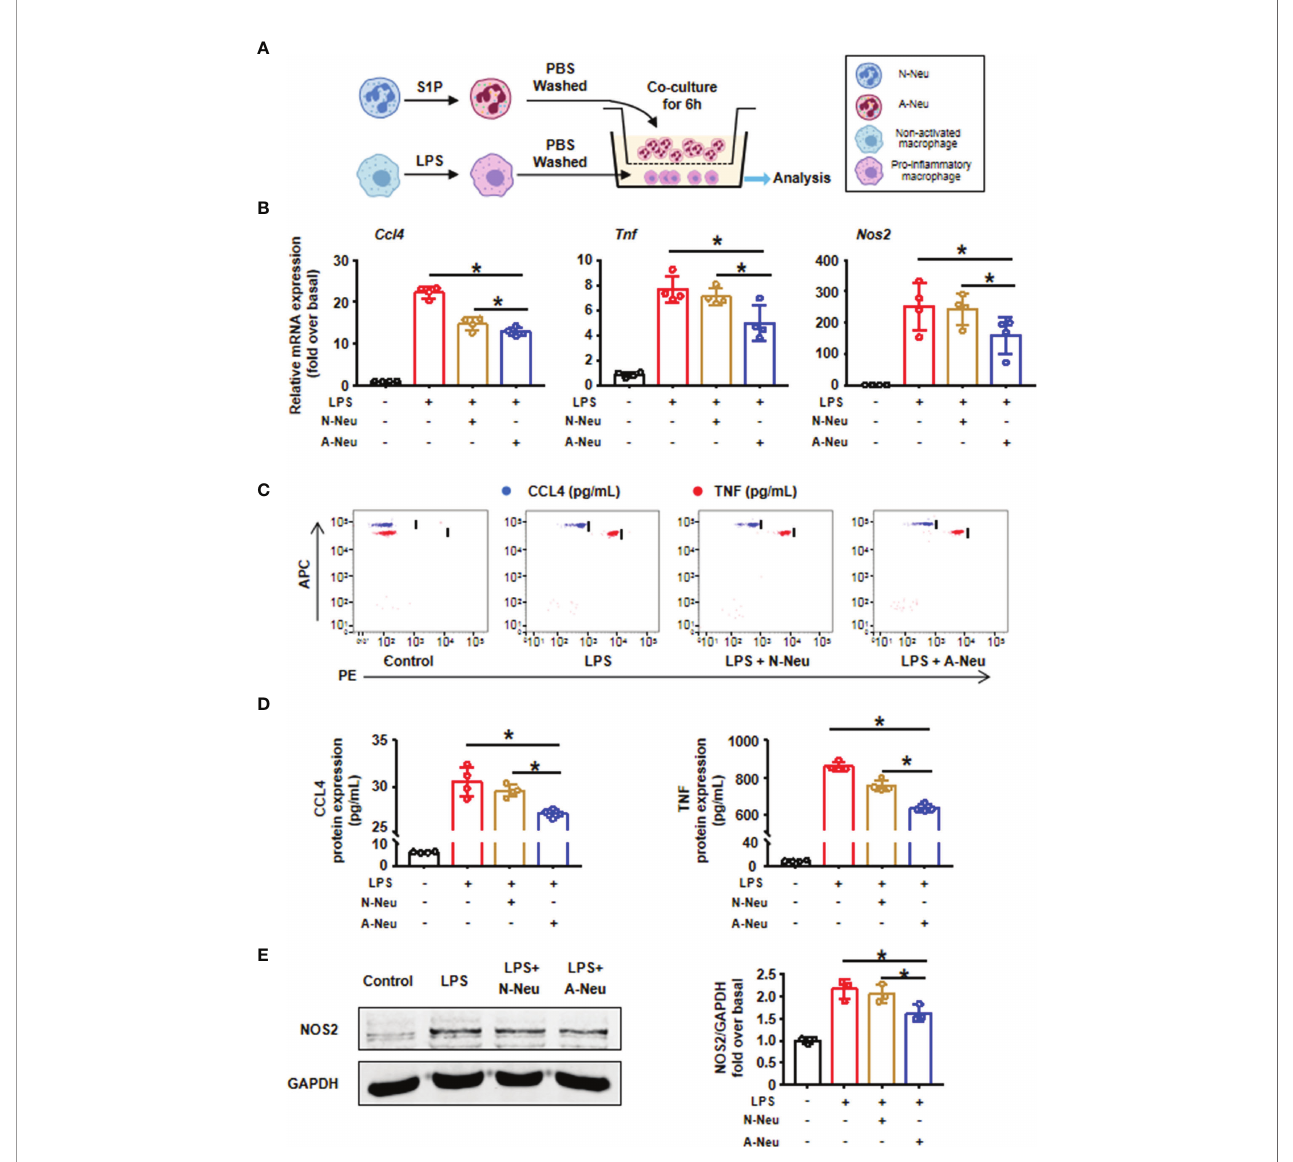
FIGURE 3 | A-Neu inhibited the pro-in fl ammatory phenotype of macrophages in vitro . (A) Schematic representation of the experimental design:bone marrow-derived macrophages were polarized into pro-in fl ammatory phenotype with LPS 10 ng/mL for 3 hours, and then PBS washed the cells, at 6 hours after the co-culture with N-Neu or A-Neu,macrophages were harvested. (B) The mRNA expression levels of genes Ccl4 , Tnf and Nos2 were evaluated using RT-qPCR,presented relative to Gapdh , (n=4). The protein expressionsof CCL4, TNF andNOS2 inliver weredetected byCBA (C,D) , n=4, and WB (E) , n=3. The results were presented as mean ± SD. One-way ANOVA was used.*P < 0.05. A-Neu, activated neutrophil; N-Neu,non-activatedneutrophil; Ccl4, C-C chemokinemotifligand 4; Tnf, tumor necrosisfactor; Nos2, nitric oxide synthase 2; LPS,